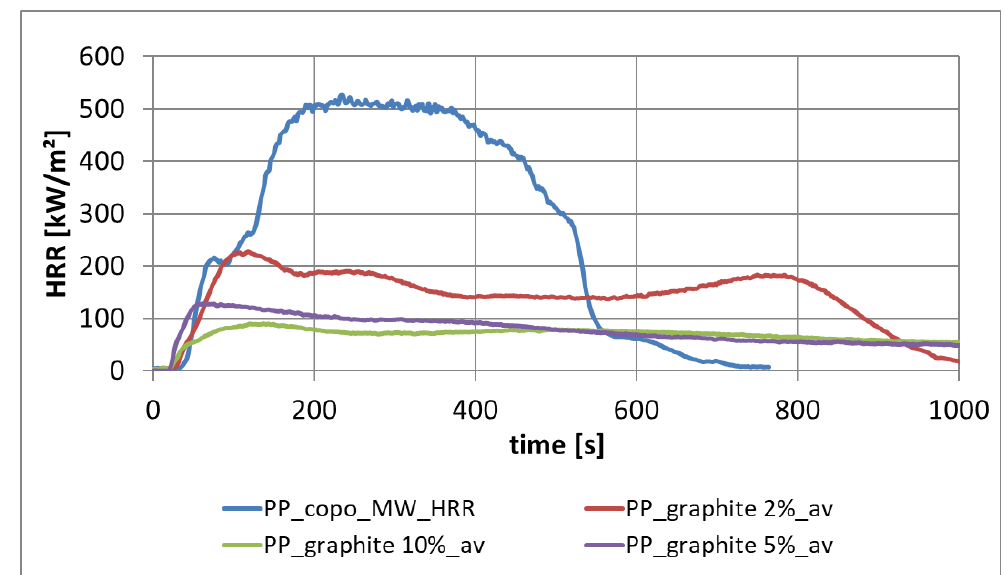
Figure 12. Heat release rate of PP-Copo with different portions of expandable graphite .